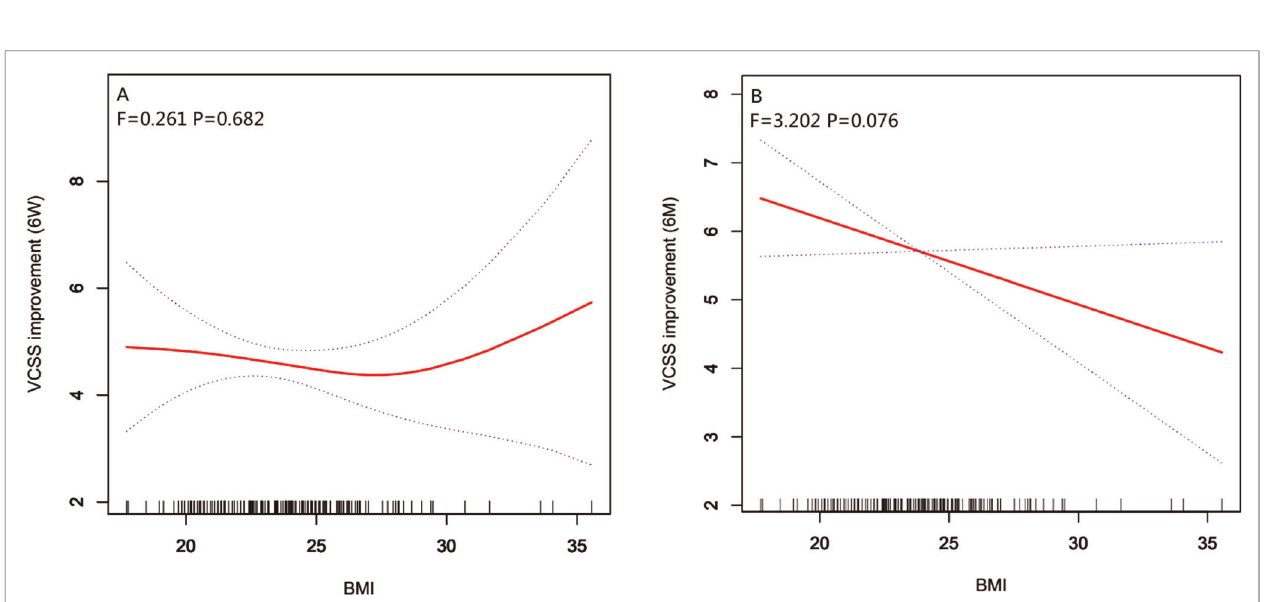
FIGURE 1 | Smooth curve fi tting for the relationship between BMI and the improvement of VCSS at 6 weeks and 6 months after surgery *. *: Adjust I adjust for: Gender; Years; Limbs; Preoperative CEAP; Preoperative AVVQ; Preoperative VAS; Preoperative QoR15-A; Preoperative